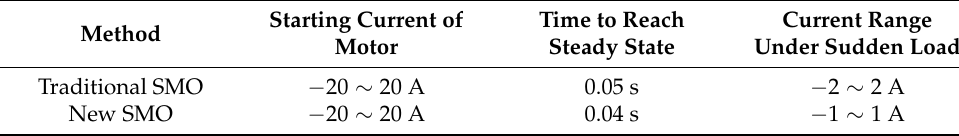
Table 5. Comparison of simulation results of three-phase current.